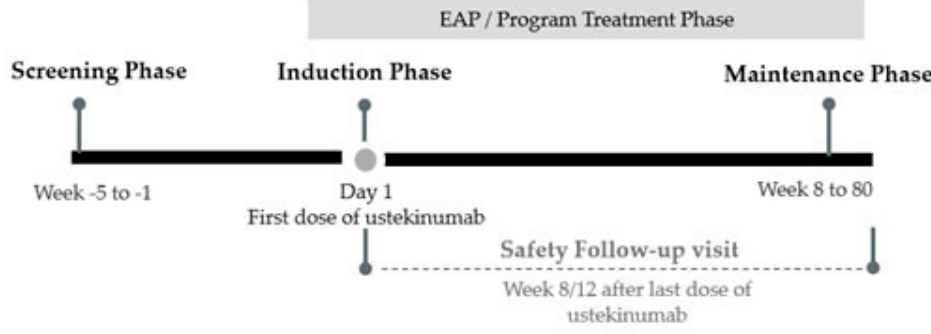
Figure 1. Schematic overview of program. EAP: early-access-program.